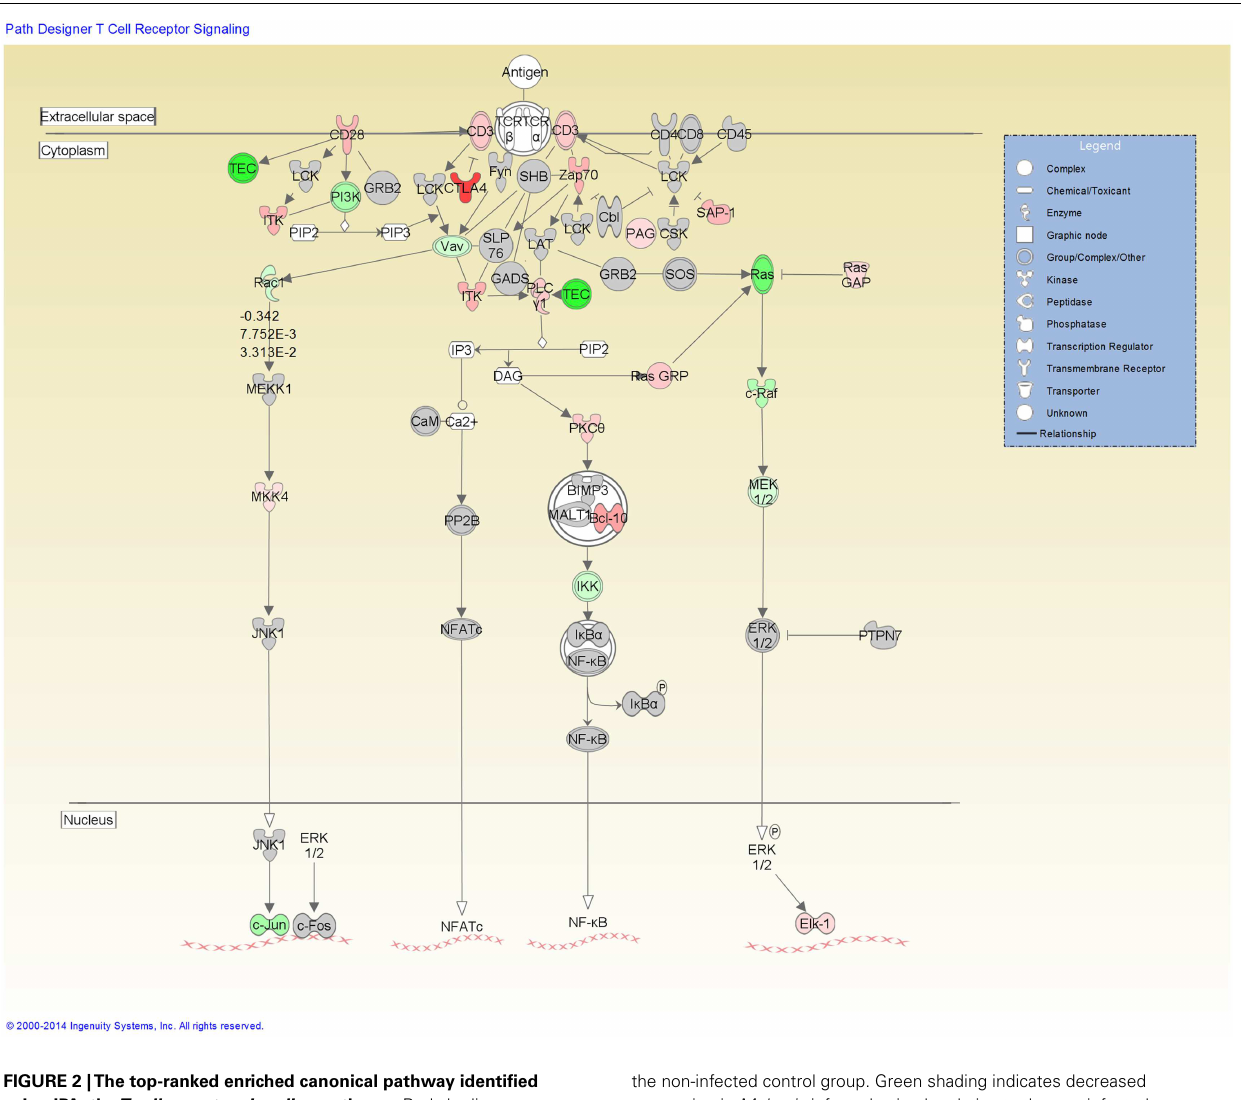
the non-infected control group. Green shading indicates decreased expression in M. bovis -infected animals relative to